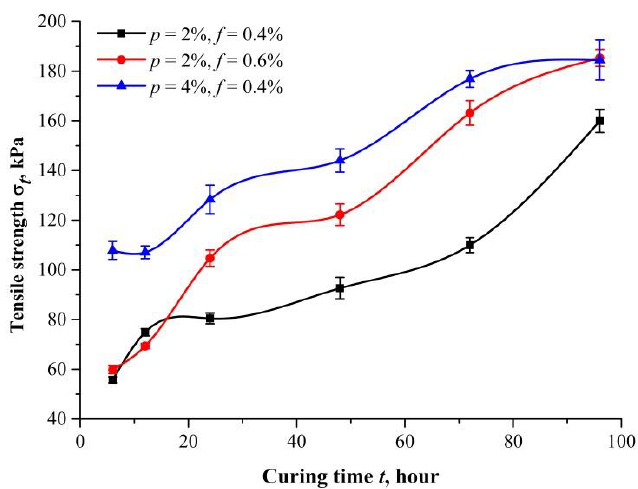
Figure 6. Tensile strength of specimens with different curing times. The bars represent standard deviations.